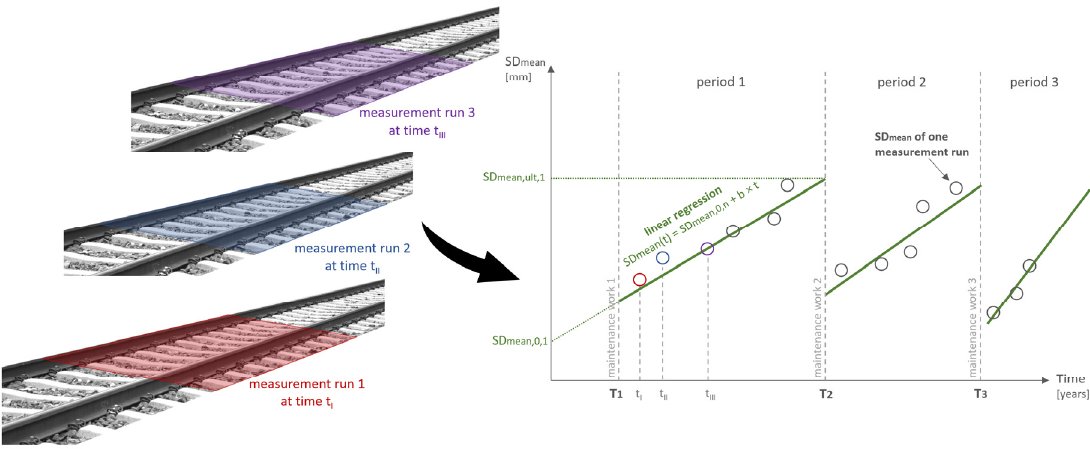
Figure 2. Time series of the longitudinal track quality SD mean and track deterioration behaviour at a specific track area (shaded in red, blue, and violet for three exemplary measurement runs).